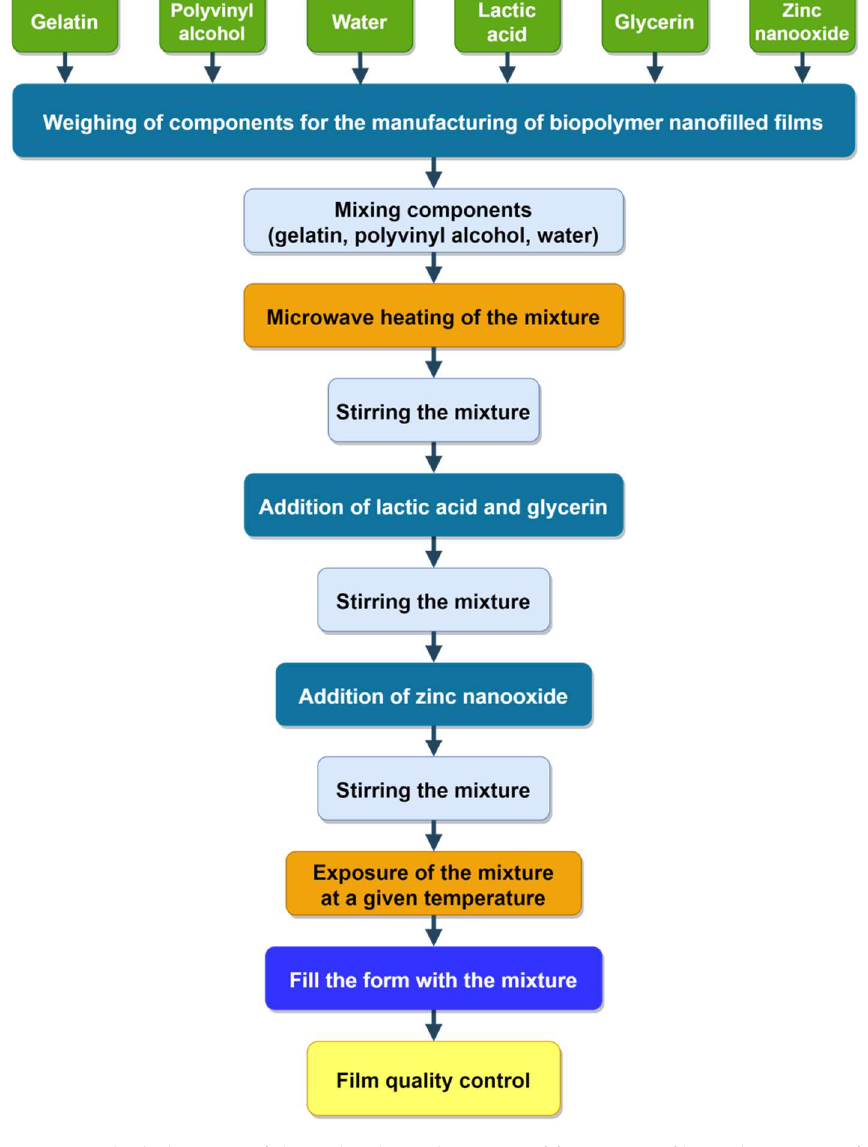
Figure 1. Block diagram of the technological process of formation of biopolymer nanofilled films.